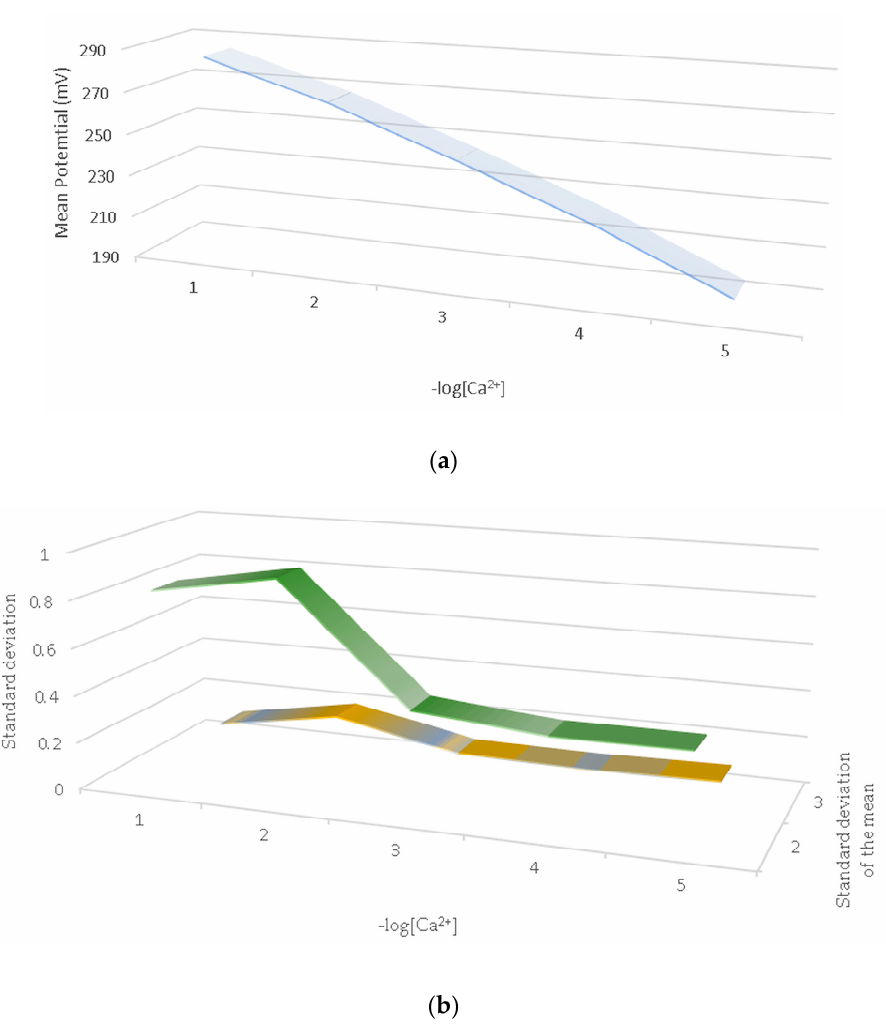
Figure 1. ( a ) Mean potential; ( b ) statistical